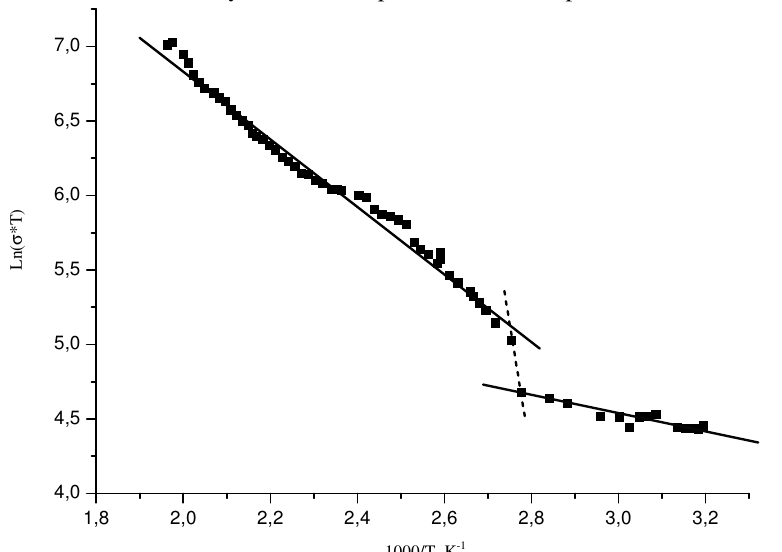
Figure 6. Arrhenius plot ln( σ T) versus 1000/T of the synthesized